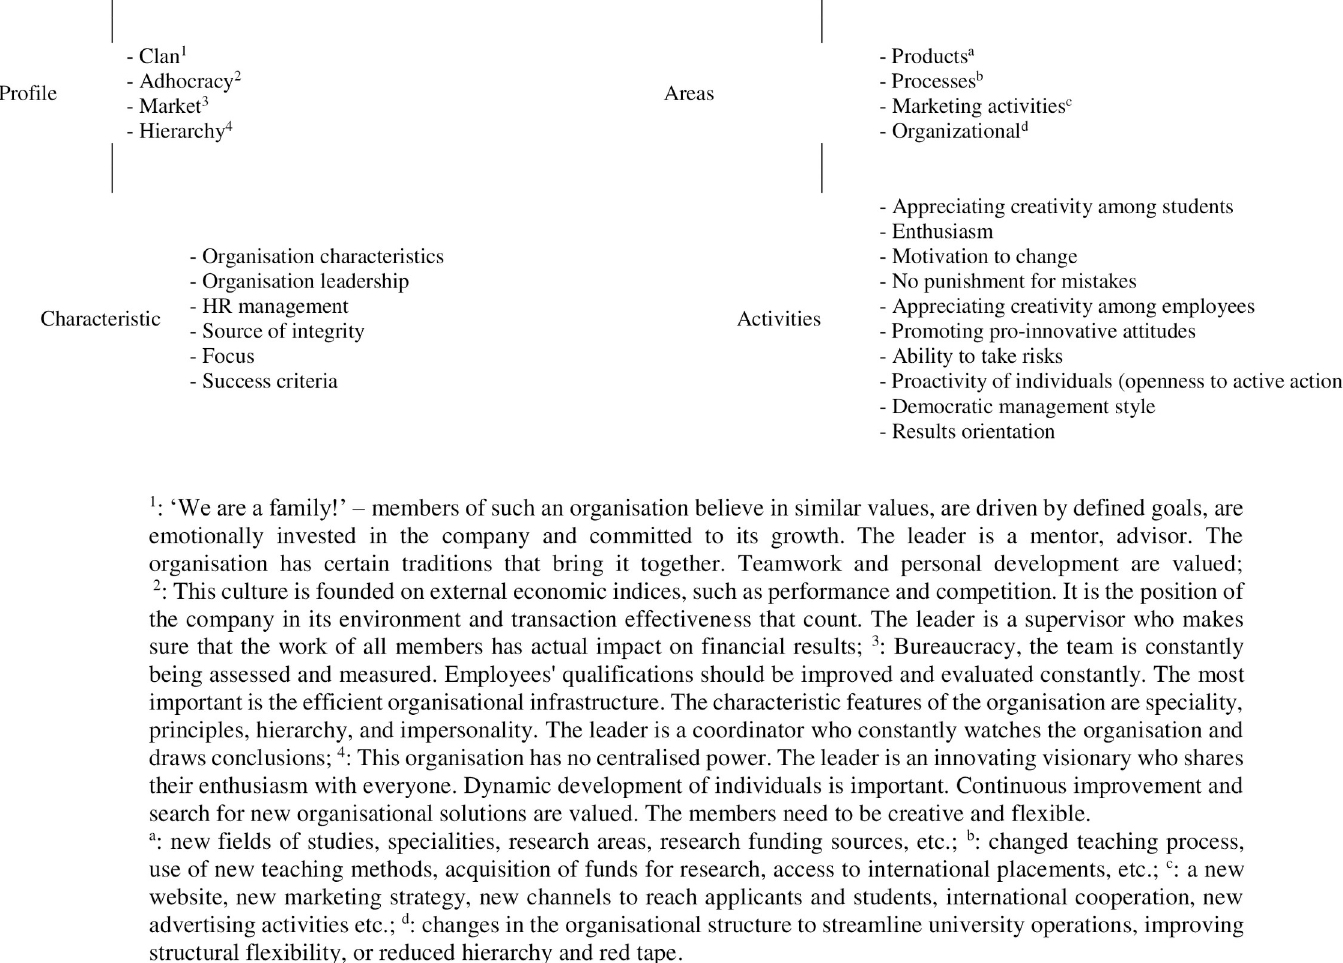
Fig 2. Main components of the original